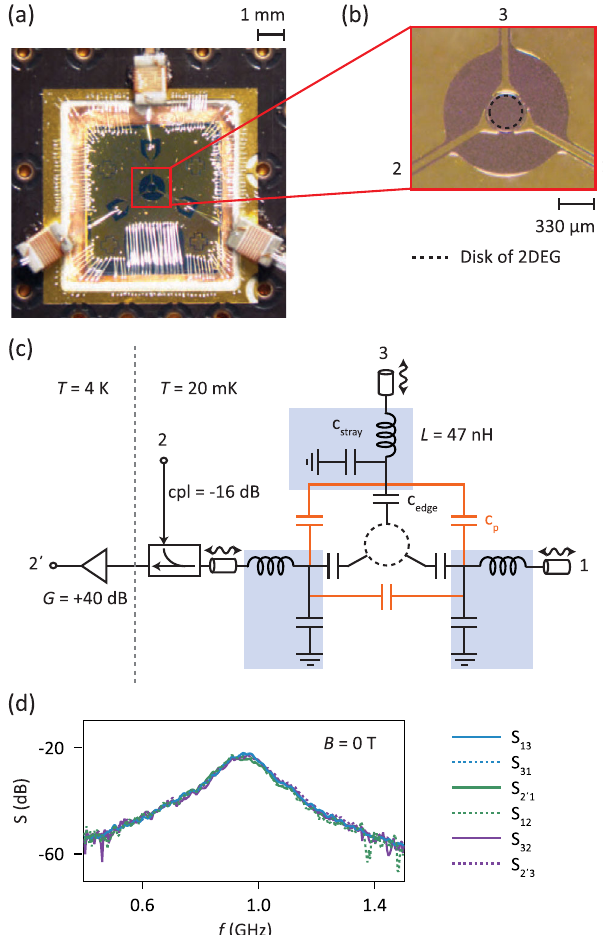
FIG. 2. Experimental setup for determining the response of the on-chip circulator. (a) Photograph of circulator device showing the three coplanar transmission lines connected to copper wire- wound chip inductors for impedance matching. (b) Close-up of false-colored photo of the circulator showing a 330 - μ m diameter 2DEG disc with a 20 - μ m gap to the metal defining the three signal ports. (c) Circuit schematic of the experimental setup indicating port-to-edge capacitive coupling C and direct edge parasitic coupling between ports C . Resonant ( LC ) matching p stray circuits are indicated with blue boxes. The input of port 2 passes through a directional coupler, with the reflected signal coupled to the output line (denoted 2 0 ) and amplified at 4 K. (d) Full six-way transmission response of the circulator at zero magnetic field, with S -parameter measurements indicating complete reciprocity and a frequency response that arises from the matching networks. For each port, the measured response of the amplifiers, couplers, and cold attenuators in the circuit has been